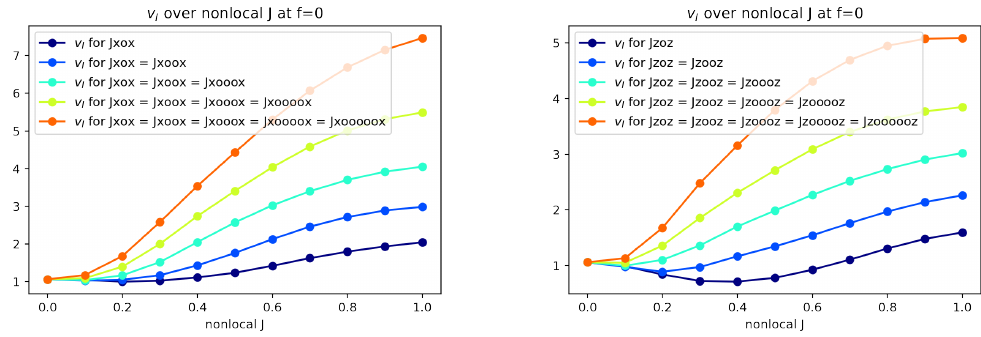
Figure 6 . Left: information velocity as a function of nonlocal σ x couplings, at f = 0 . Nonlocal terms are turned on up to fixed “width”. Right: information velocity as a function of nonlocal σ z couplings, at f = 0 . Nonlocal terms are turned on up to fixed “width”.